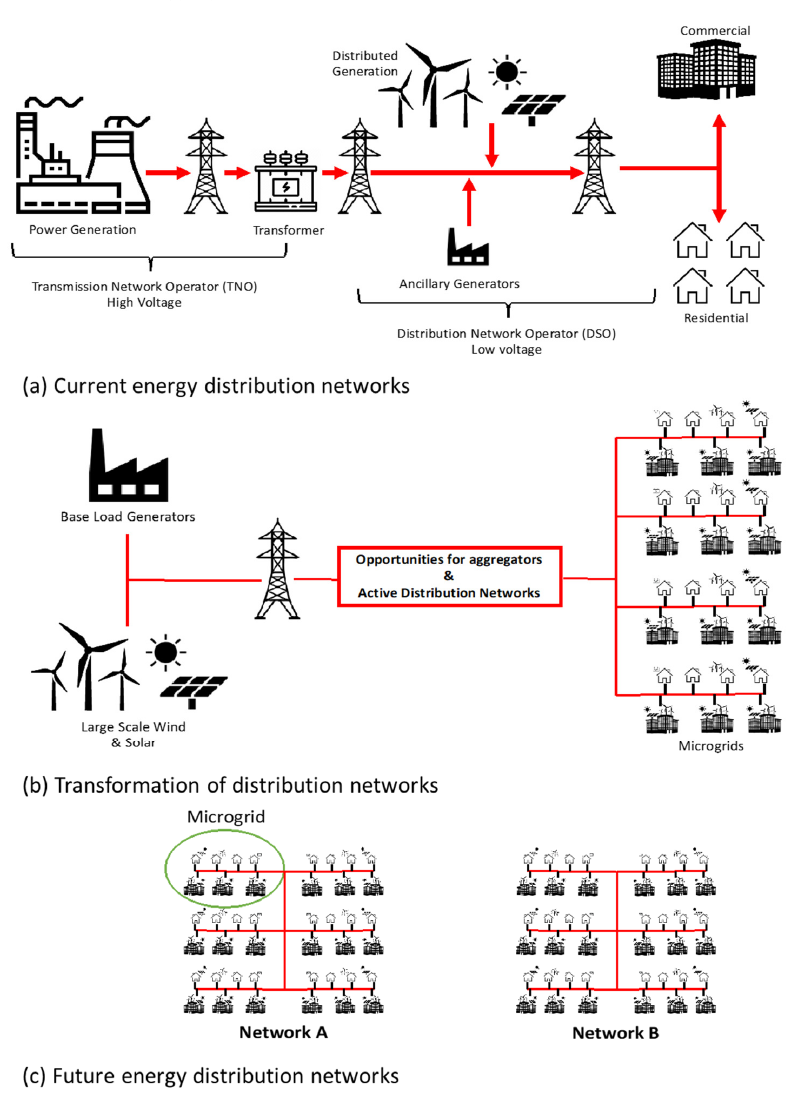
Figure 1. Transformation of the distribution network.